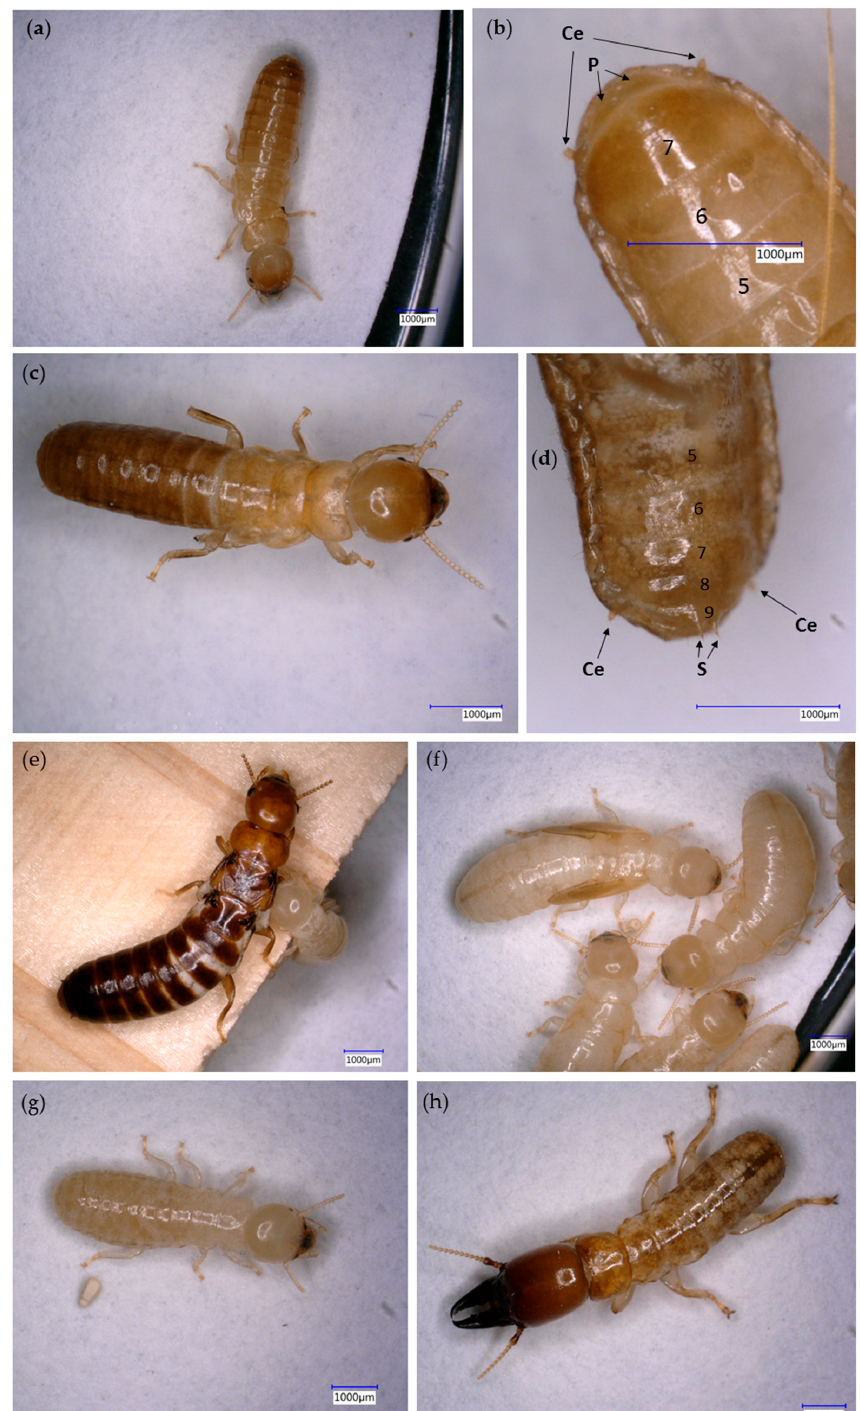
Figure 6. Caste profile of I. minor colony. ( a ) A neotenic reproductive emerged from the colony in Spruce A timber and was identified as a ( b ) female neotenic; ( c ) a neotenic reproductive emerged from the colony in Spruce B timber and was identified as ( d ) male neotenic; ( e ) a queen (primary reproductive) from the colony in the Sugi timber; ( f ) nymphs; ( g ) a “false” worker; and ( h ) a soldier. Ce, cerci; P, paraprocts; S, styli. The numbers in Figure 6b,d indicate sternite segments.